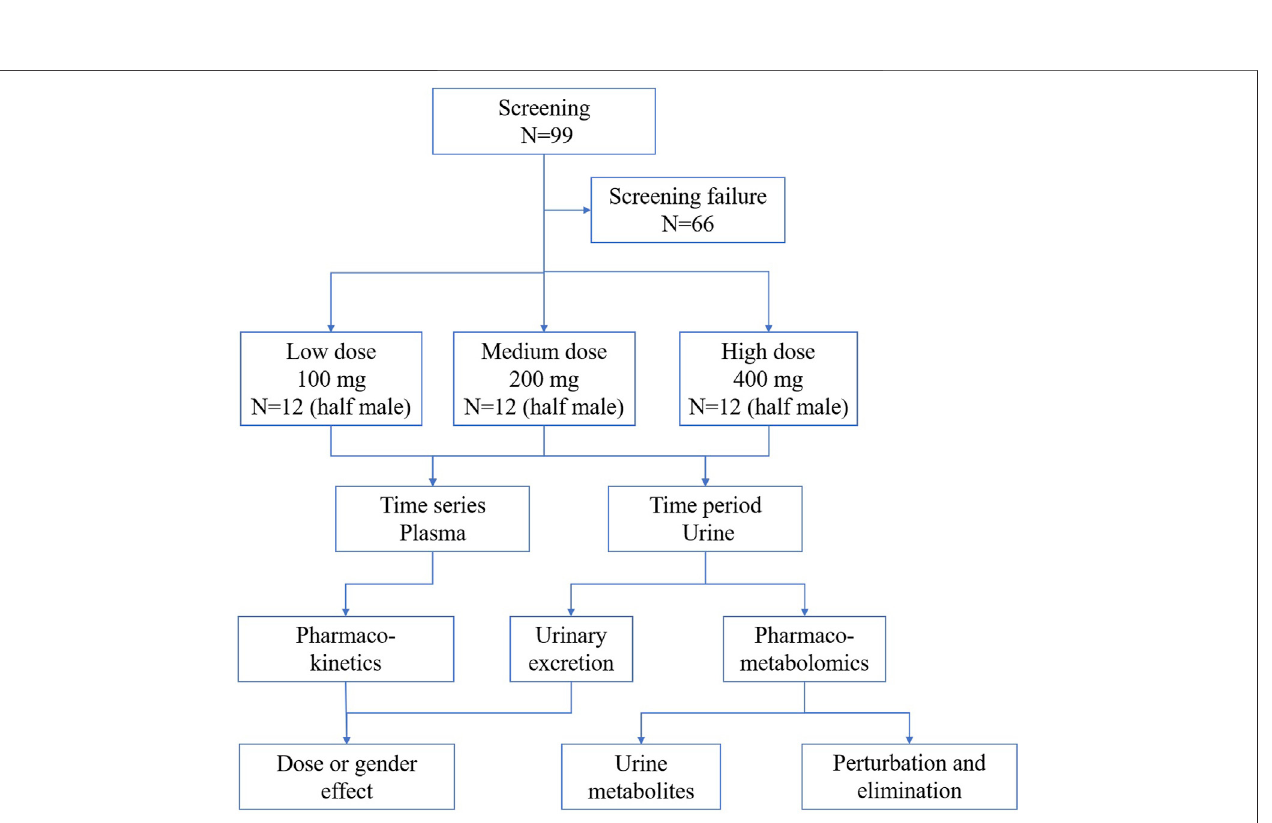
FIGURE 1 | Flowchart of the current